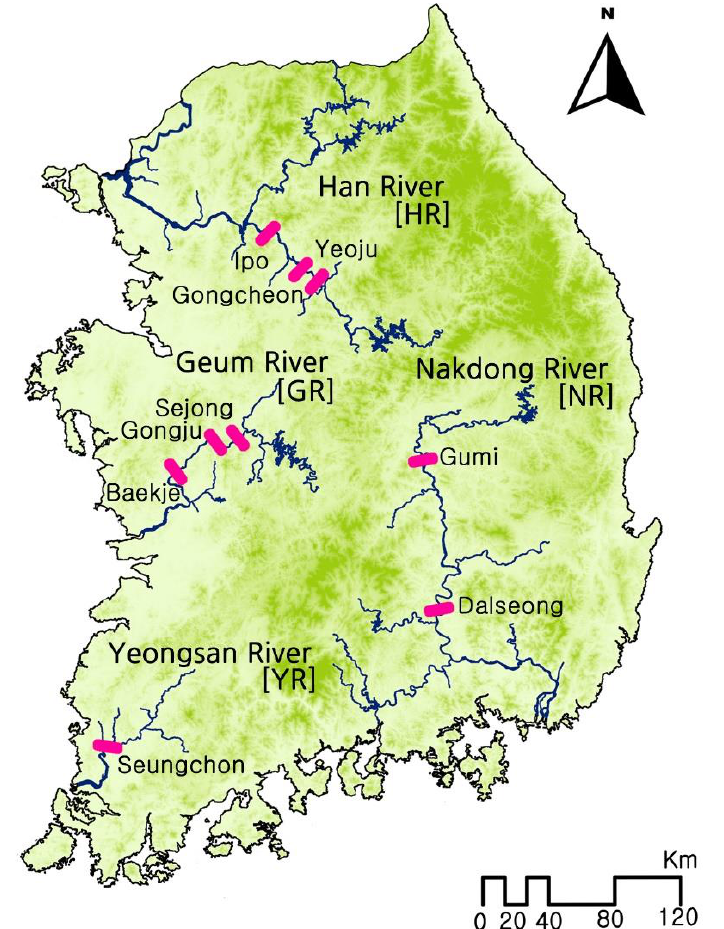
Figure 1. Sampling sites along the four largest rivers in South Korea. Sampling was conducted at 0.3 – 1 km upstream of weirs (pink marks) at each site.